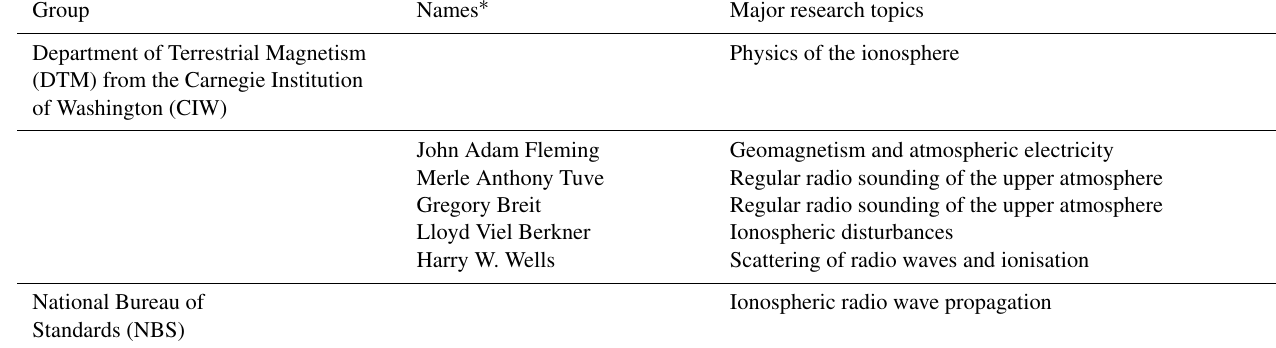
Table 2. Ionospheric physics in the United States in the interwar years. Groups and major research topics. Group Names